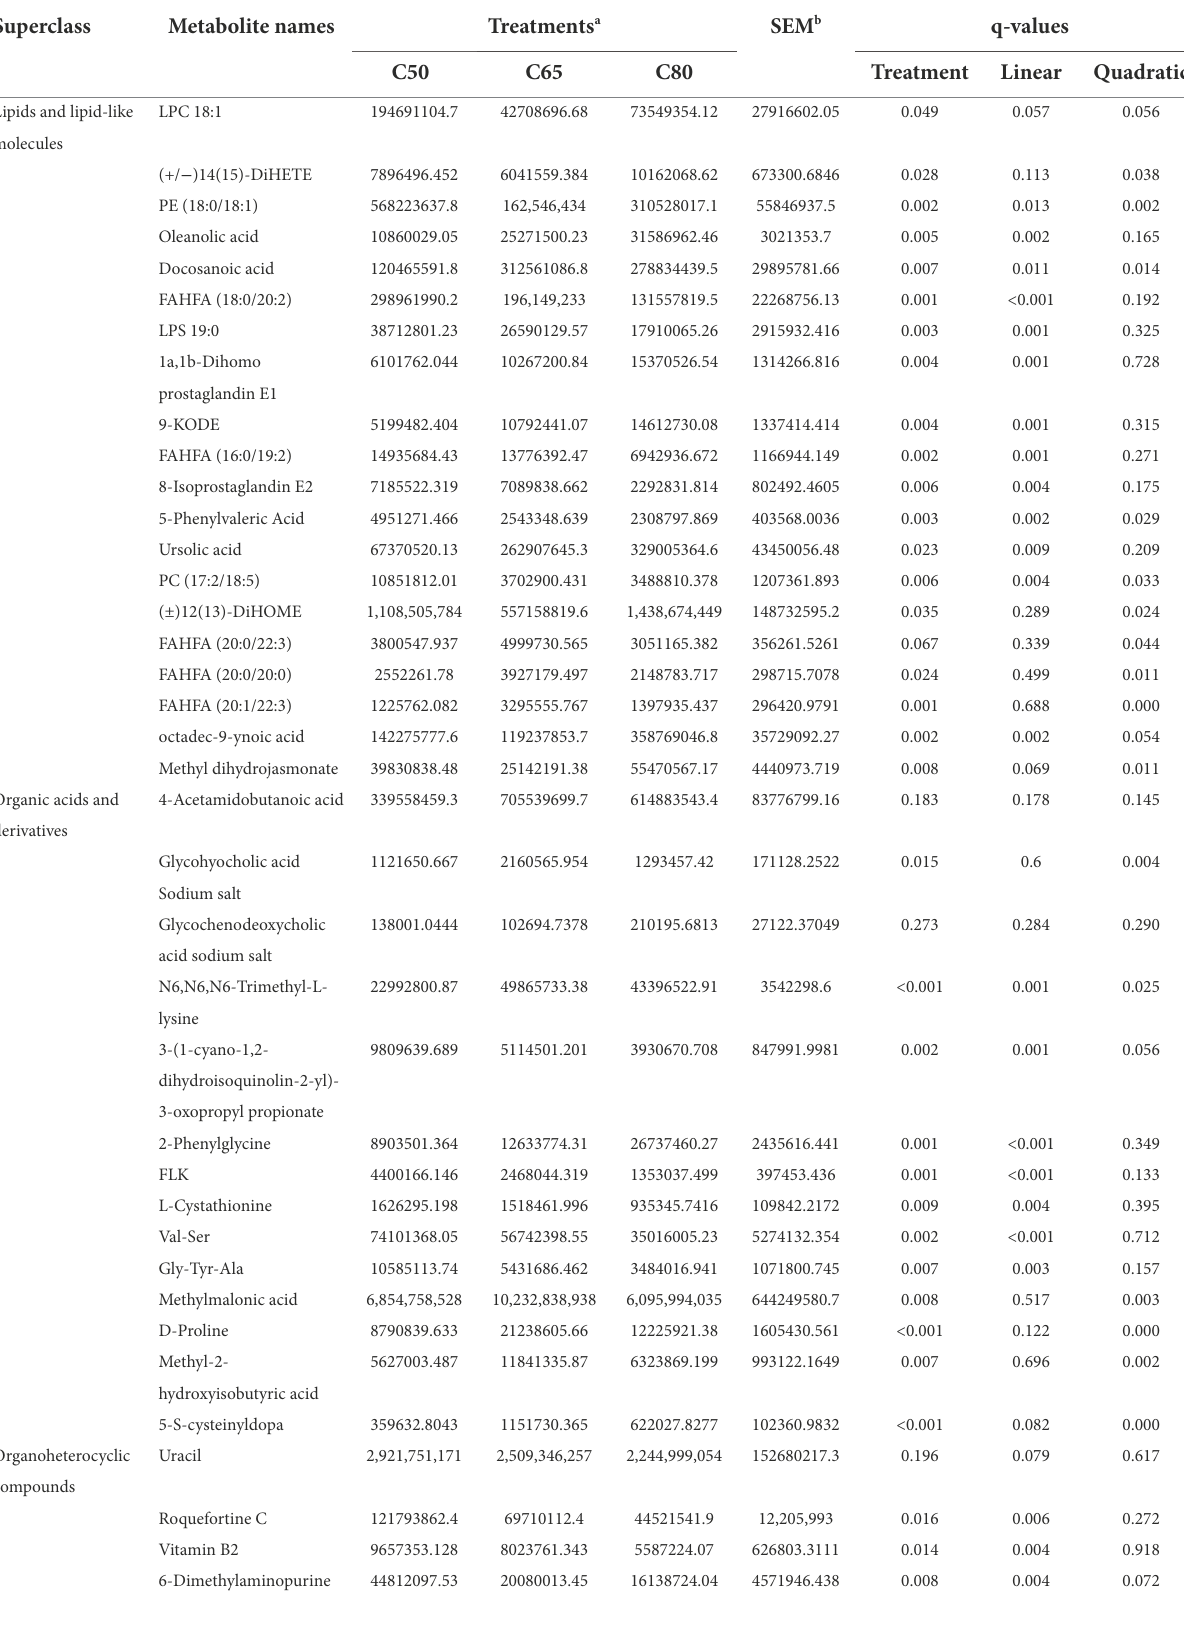
TABLE 3 Comparison of significantly changed rumen metabolites in three